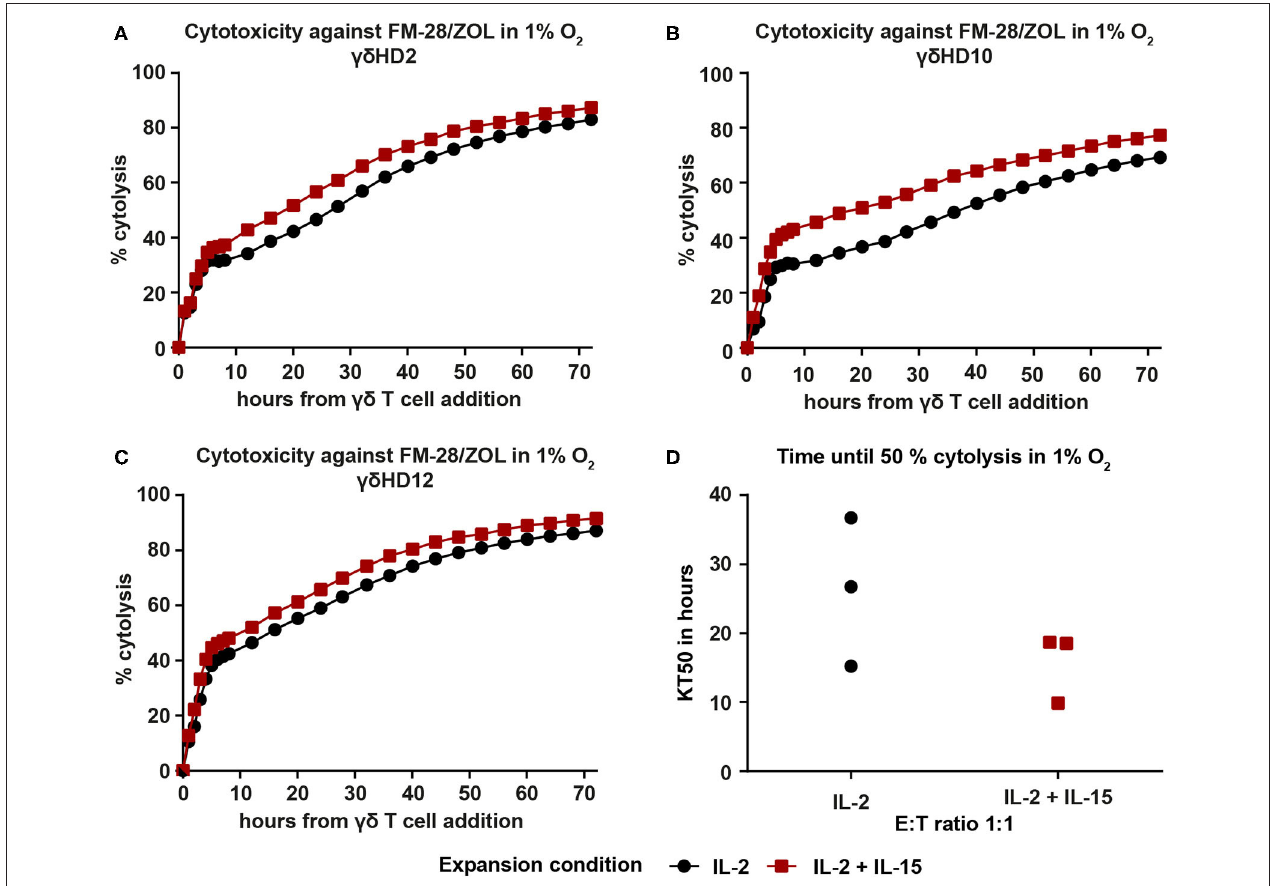
FIGURE 6 | IL-2/IL-15-expanded V γ 9V δ 2T cells retain increased cytotoxicity against FM-28/ZOL under hypoxic conditions. FM-28 cells were cultured in hypoxia for 5 days prior to seeding in the xCELLigence and stimulated with 10 µ M ZOL for the last 24h. 25-day-expanded V γ 9V δ 2T cells were added at an effector–target ratio of 1:1 and cytolysis monitored for 72h in 1% O 2 . Cytolysis plots of donors (A) γδ HD2, (B) γδ HD10, and (C) γδ HD12 comparing cytotoxicity against FM-28/ZOL between expansion conditions in 1% O 2 . Black, round symbols mark IL-2-expanded cultures, while red, square symbols mark IL-2/IL-15-expanded cultures. (D) Time to kill 50% of target cells FM-28/ZOL (KT50) is depicted for IL-2-expanded and IL-2/IL-15-expanded V γ 9V δ 2T cell at an effector–target ratio 1:1 ( n = 3 in one experiment; γδ HD2,10,12). % cytolysis and KT50 were calculated with the xCELLigence RTCA Software